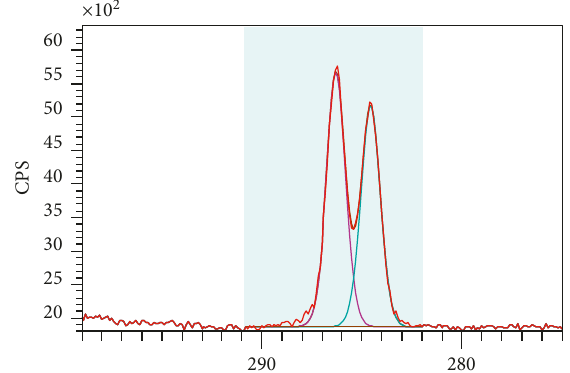
Figure 3: High-resolution X-ray photoelectron spectroscopy spectra of